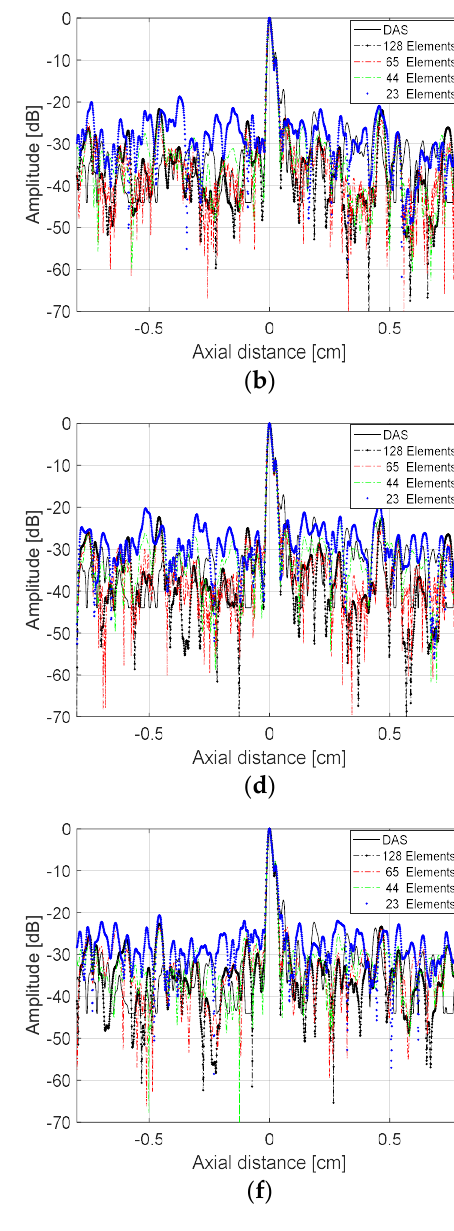
Figure 11. Lateral and axial resolution results for the target at 2.0 cm depth, shown in Figure 10, for the plane wave excitation and DAS method. Plane wave excitation with angles ranging ( a , b ) −1.5 to +1.5°, 0.5° step; ( c , d ) −3.0 to +3.0°, 1.0° step; ( e , f ) −15.0 to +15.0°, 5.0° step, and reception with 128 (non-sparse), 65, 44, and 23 active elements (sparse conditions).